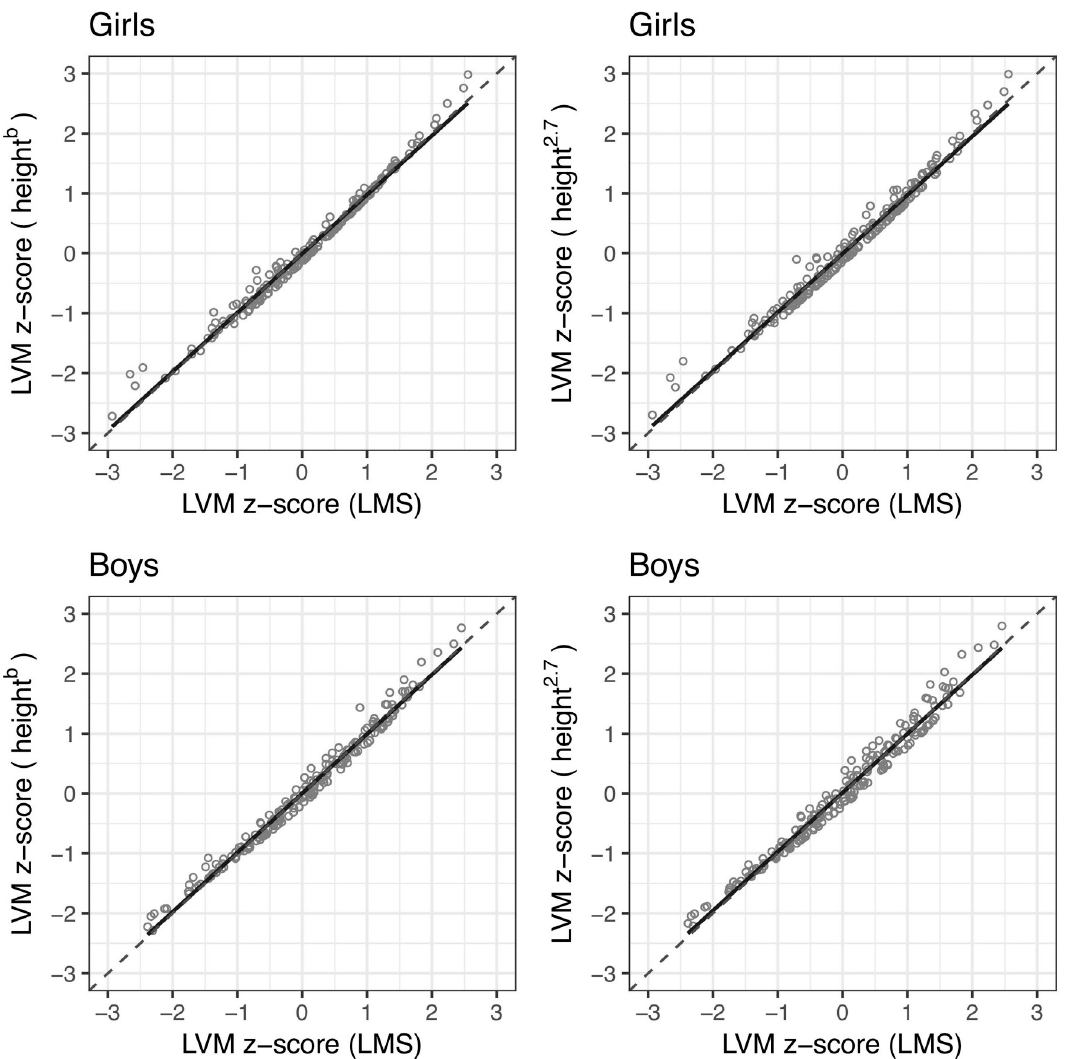
Fig 1. Scatter plots of the LVM z-scores calculated based on the allometric normative data against the LVM z-scores calculated based on the LMS normative data. On each chart, the regression line is fitted to the data points (solid line), and the equality line is shown (dashed line). The charts on the right correspond to the height b variant and those on the left to the height 2.7 variant. The upper charts are for girls and the lower for boys. (1.0340), and 0.0378 (1.0344), respectively. The mean differences between the z-scores calcu- lated based on both allometric LVM normative data sets and based on the LMS normative data did not differ from 0, for both female subjects and male subjects. The height b and height 2.7 allometric LVM z-sores, separate for girls and boys, are plotted against the LMS z-score in Fig 1. These scatter graphs show that, for both variants, data points are congregated along the equality line, and the best fit line overlaps the equality line. Table 3 presents the results of statistical analyses that test the agreement between the allo- metric normalization methods and the LMS method. The coefficients of the regression lines indicate that the best-fit lines are very close to the equality line. The y-intercepts of the best-fit lines are close to 0 and are non-significant (the lines pass through the origin). The slopes of the lines are close to 1 and are significant, as are the Pearson correlation coefficients.